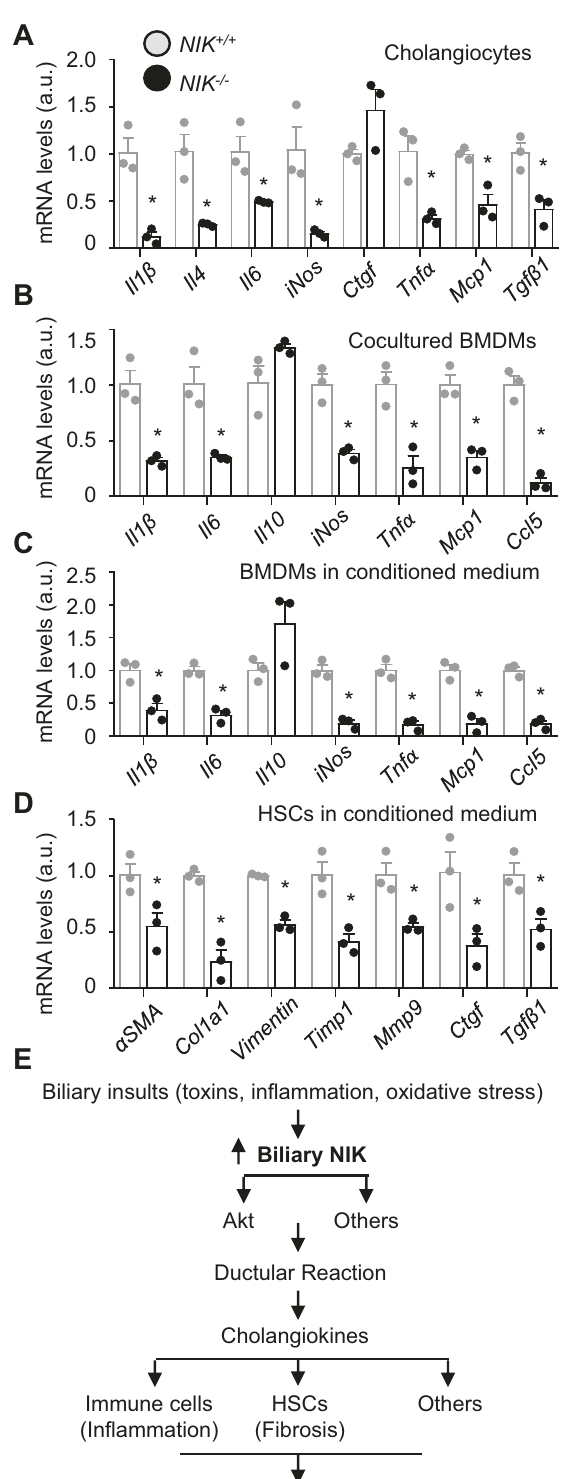
Fig. 7 | Biliary NIK regulates cholangiocyte-macrophage and cholangiocyte- HSC crosstalk via cholangiokines. A Cholangiocyte cultures were treated with TWEAK (50ng/ml) for 48h. Gene expression was measured by qPCR and normal- ized to 36B4expression ( n =3 repeats per group). B BMDMs were cocultured with TWEAK-stimulated cholangiocytes for 24h, and BMDM gene expression was measured by qPCR and normalized to 36B4 expression ( n =3 repeats per group). C BMDMs or D HSCs were treated with cholangiocyte-conditioned medium for 6h and 24h, respectively. Gene expression was measured by qPCR and normalized to 36B4 levels ( n =3 repeats per group). E Biliary insults (biliary toxins, oxidative stress, cytokines) activate biliary NIK. NIK induces ductular reaction by enhancing, perhaps via Akt pathways, cholangiocyte proliferation while suppressing cho- langiocyte death. Additionally, NIK stimulates secretion of cholangiokines from reactive cholangiocytes. The cholangiokines activate liver immune cells and HSCs, promoting liverin fl ammation,liver fi brosis,and liverdisease progression. Dataare presented as mean±SEM. * p <0.05, 2-tailed student ’ s t